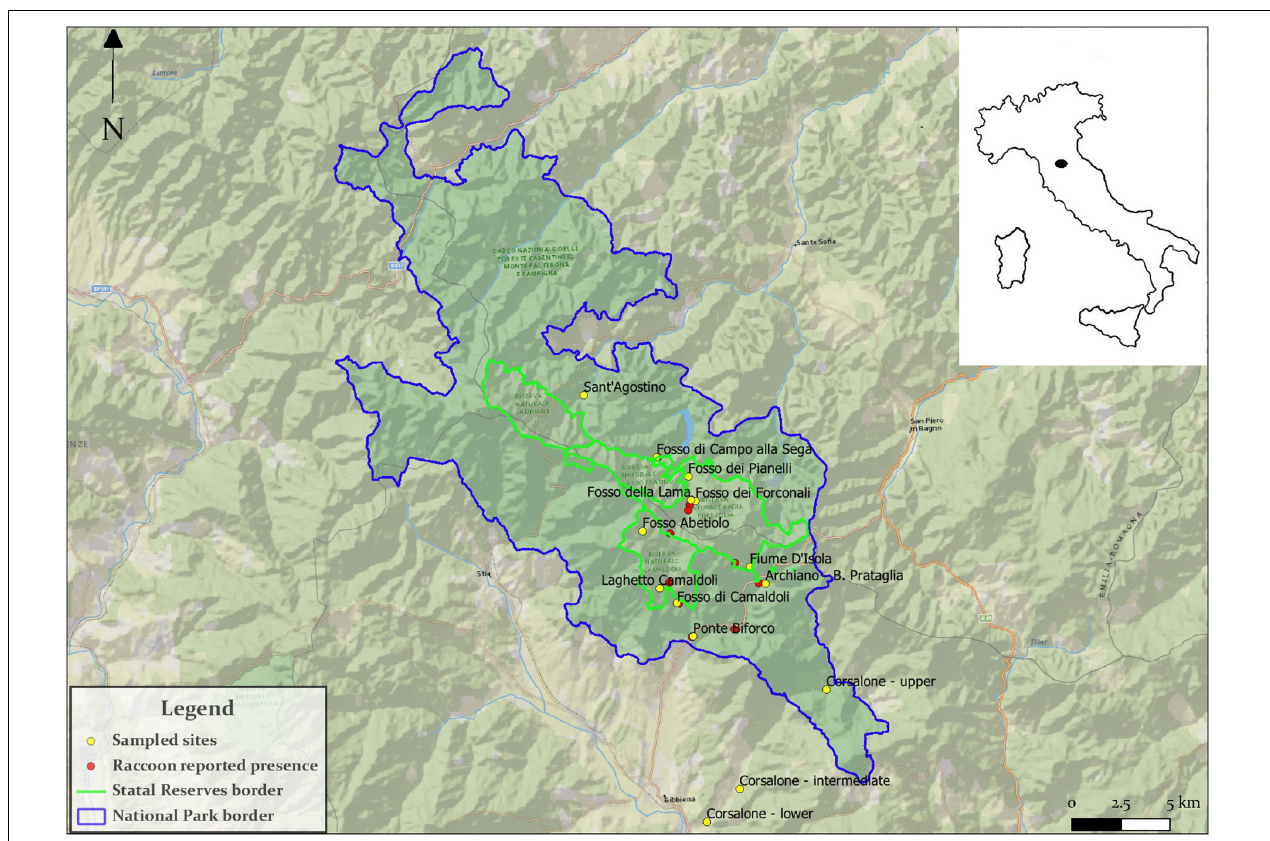
FIGURE 1 | The sampled sites in the Foreste Casentinesi, Monte Falterona, and Campigna National Park, and